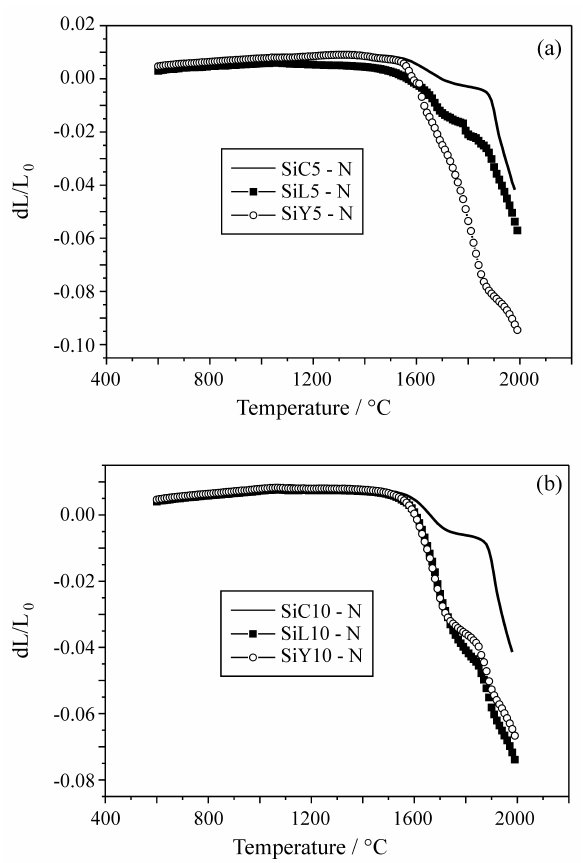
Figure 4. The results of dilatometric experiments: shrinkage rate vs. temperature while sintered in nitrogen: a) 5wt% α -SiC; b) 10wt% α